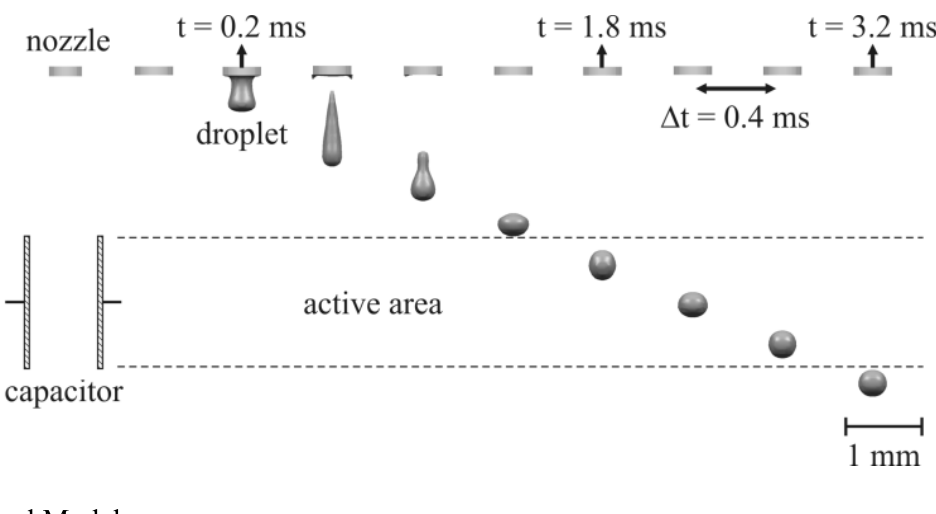
Figure 4. Simulated droplet ejection process applying the grid as described in Section 3.1. A flow (2.5 m/s) towards the nozzle is instantly stopped after 70 µs which initializes the droplet